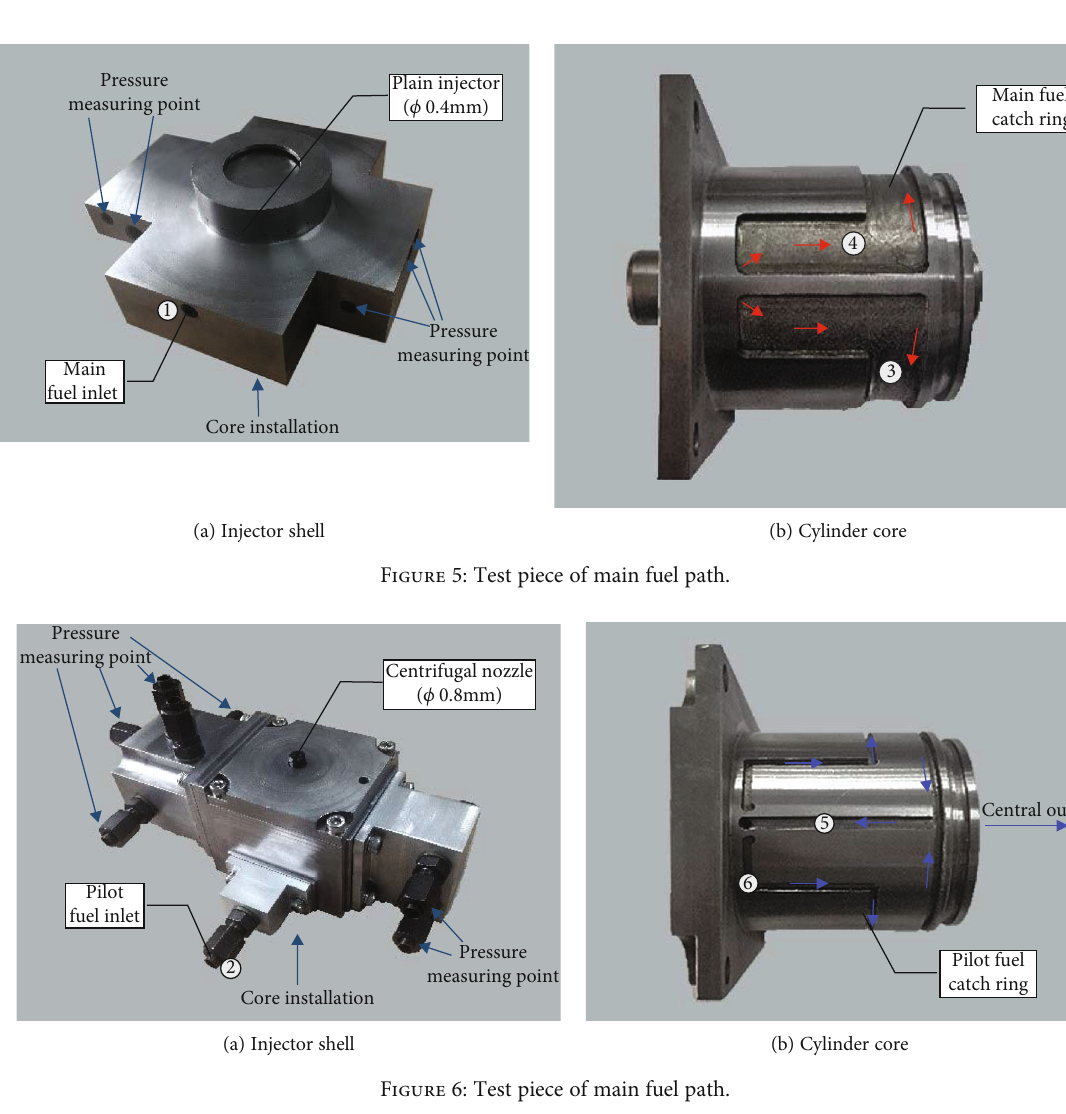
Figure 6: Test piece of main fuel path.